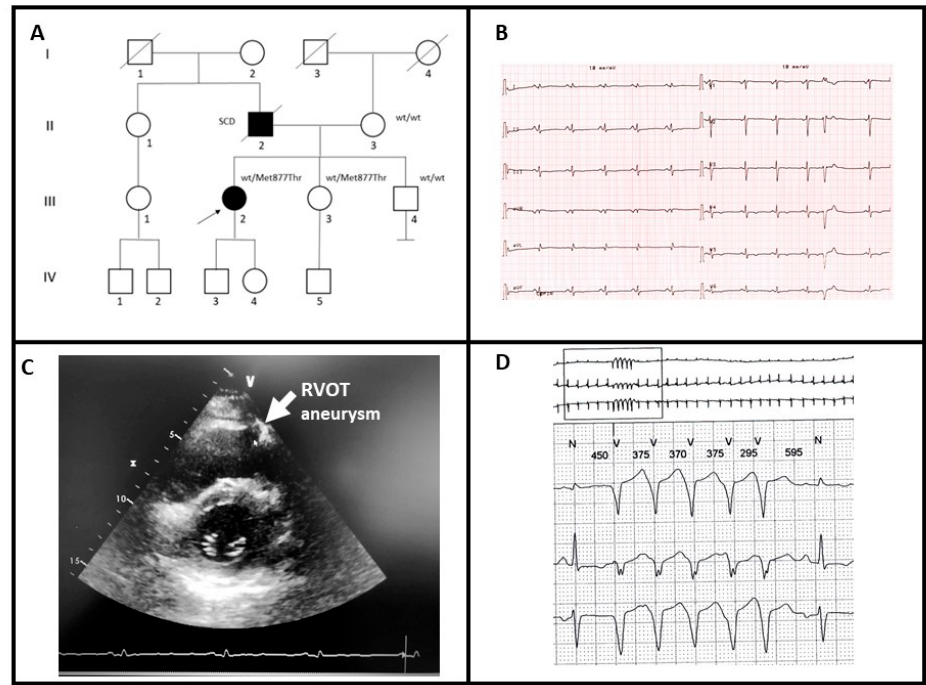
Figure 1. ( A ) Pedigree structure of family A, arrow indicates the proband affected (III-2); Met877Thr is the variant identified within MYH7 gene; ( B ) basal ECG of the proband; ( C ) transthoracic echocardiography of the proband, the arrow shows aneurysm of right ventricular outflow tract (RVOT); ( D ) 24-h ambulatory ECG monitoring showing NSVT.